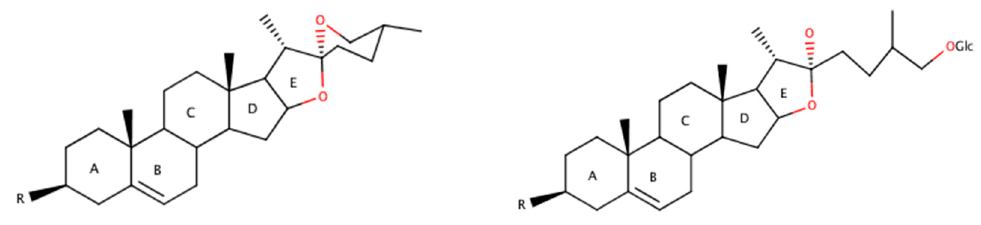
Figure 1. Spirostanol ( left ) and furostanol ( right ) saponins. Table 2. Chemical compounds identified in Tribulus terrestris